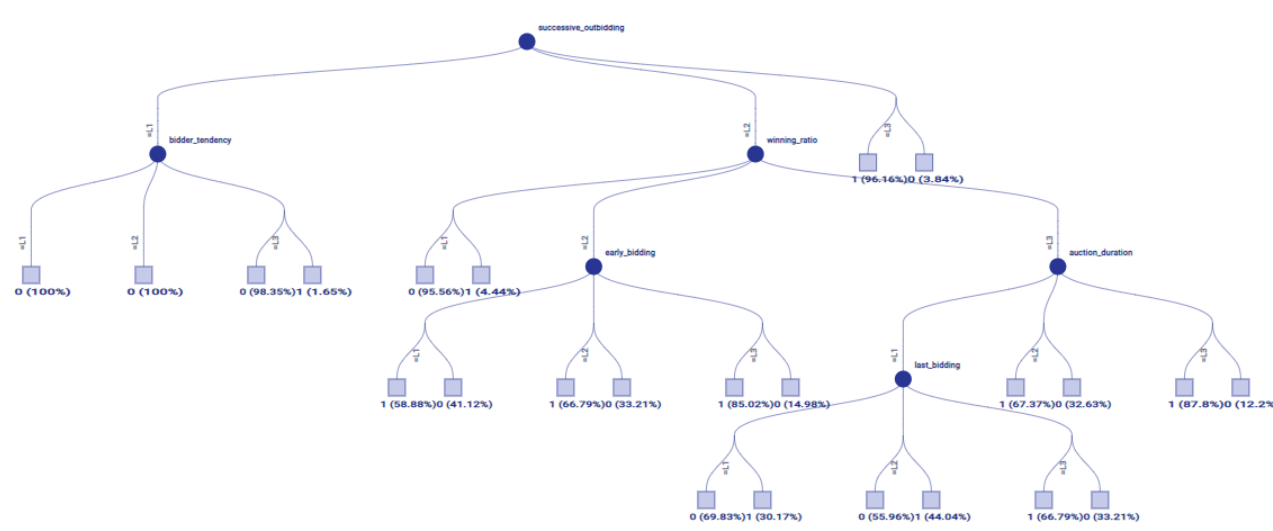
Figure 16. Fuzzy Hoeffding Decision Tree